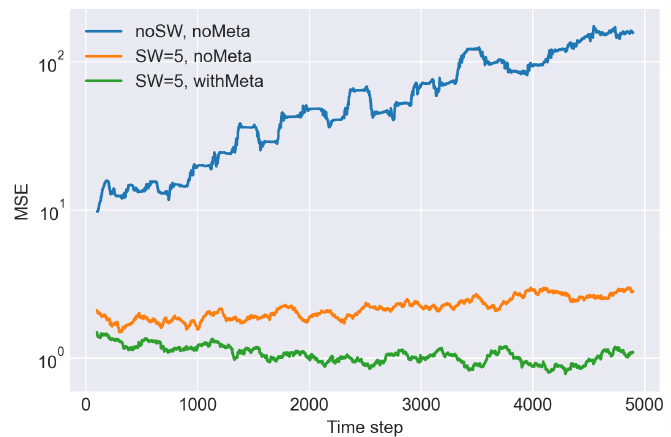
Figure 5. The figure shows the mean squared error (MSE) with 200 time step moving average for the toy regression task. The coefficients of the linear generative model change their values over time to simulate the non-stationary target. Three lines are for the different prediction models. The blue line is the result of the model without meta-learning and without sliding window. The orange line is the result of the model without meta-learning and with sliding window. The green line is the result of the model with online meta-learning and sliding window.